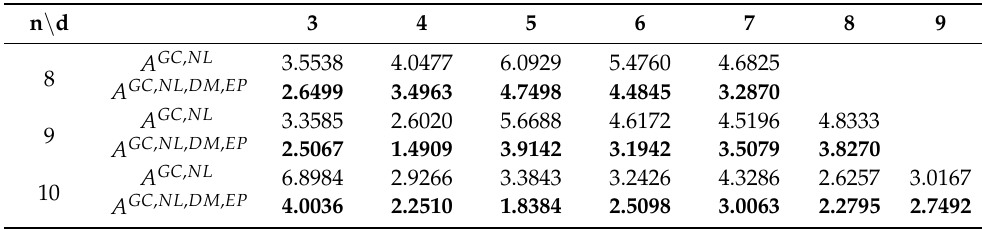
Table 10. Comparison results of the melting temperature variance, where the best results are bolded to indicate. n \